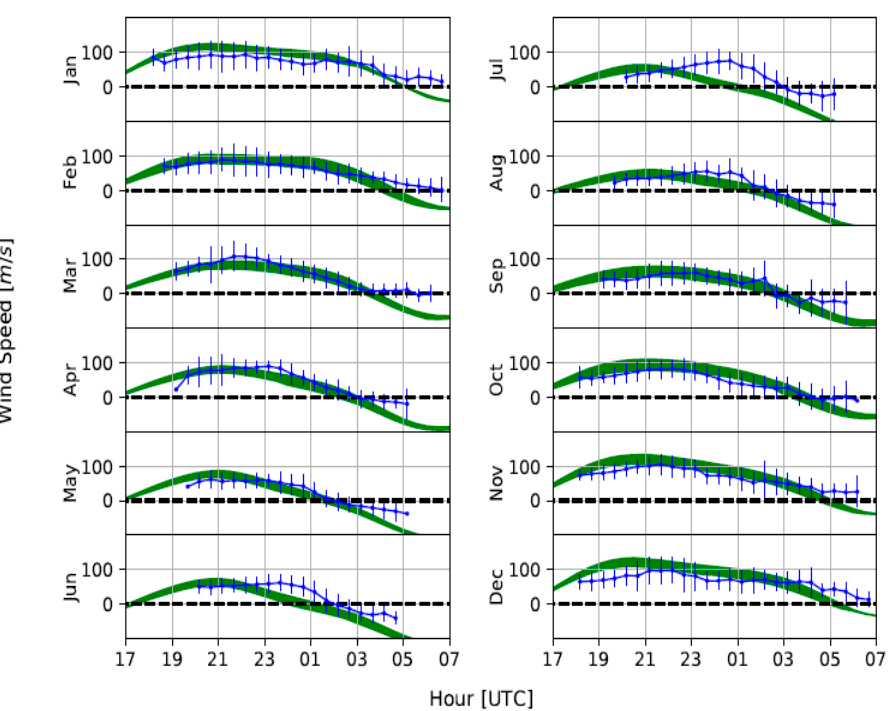
Figure 5. Zonal winds in Morocco for January 2014 to February 2016. The blue plots represent the FPI measurements, while the green plots represent corresponding HWM-14 predictions. The vertical error bars indicate the standard deviations of the observations. Adapted with permission from Ref. [23]. 2017, Kaab et al.